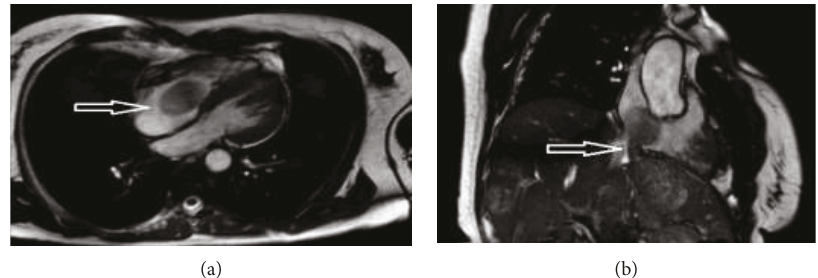
Figure 5: Cardiac MRI con fi rms the mass in (a) the right atrium with prolapsing through the tricuspid valve and (b) the contiguous extension of the liver metastasis to the IVC and right atrium (white arrows).